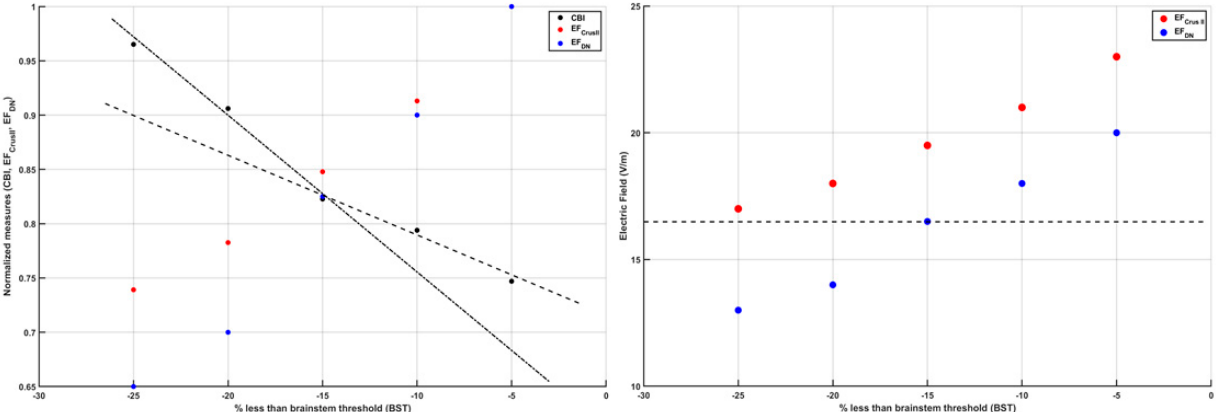
Figure 3. Left panel shows the change in cerebellar brain inhibition (CBI) from a neurophysiological study and change in normalized (by maximum) electric field strength at Crus II and dentate nuclei (DN) with the change in the intensity of the transcranial magnetic stimulation (TMS) as a percentage less than the brain stem threshold (BST). Right panel shows the electric field strength (V/m) at Crus II and dentate nuclei (DN) with the change in the intensity of the TMS as a percentage less than the BST. It is postulated that − 15% less than the BST (dashed line in the right panel) is the TMS intensity at which the DN begin to be activated by the TMS (as represented by the change in the slope described by the dashed and dash–dot lines in the left panel).